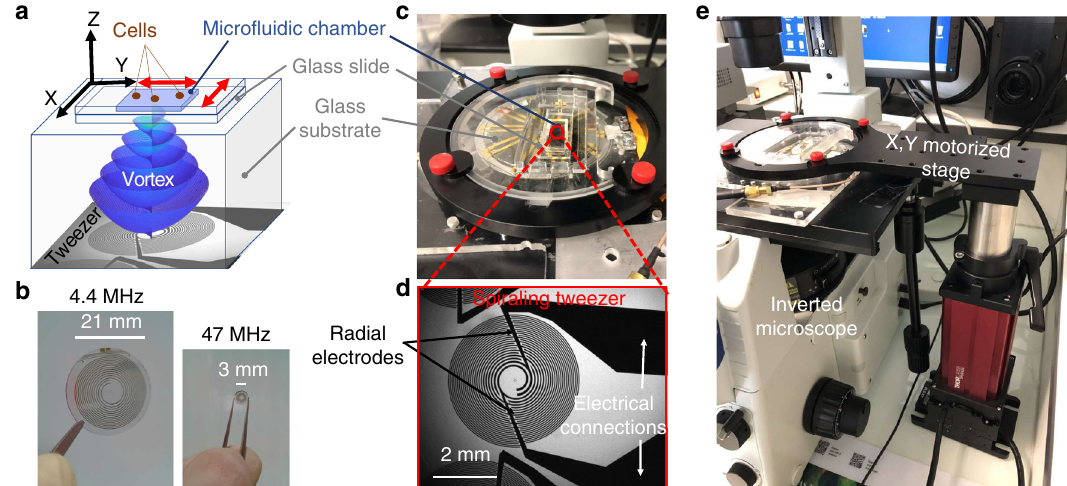
Fig. 1 Experimental setup. a Illustration of the working principle of the tweezers designed for cells ’ selective manipulation: A spherically focused acoustical vortex is synthesized by spiraling active electrodes metallized at the surface of a piezoelectric substrate and actuated with a function generator connected to an ampli fi er. The vortex propagates and focalizes inside a glued glass substrate and then reaches a micro fl uidic chamber made of a glass slide and a PDMS cover containing cells embedded in a growth medium. The micro fl uidic device is acoustically coupled with the transducer with a thin layer of silicone oil (25 cSt). A cell located at the center of the acoustical vortex is trapped. Its motion relative to other cells is enabled by the displacement of the micro fl uidic chamber driven by a XY motorized stage (see Supplementary Movie 1 for an animated explanation of the setup working principle). b Picture of typical transducers used in the present study (right) and illustration of the scale reduction compared to previous lower frequency designs by Baudoin et al. 30 (left). c Image of the actual experimental setup. d Zoom-in on the spiral transducer and the electrical connections (in black). e Illustration of the integration of the whole setup inside a standard inverted microscope. Photo credit: B: J.-C. Gerbedoen, SATT NORD/C-D-E: R.A. Sahely, Univ.